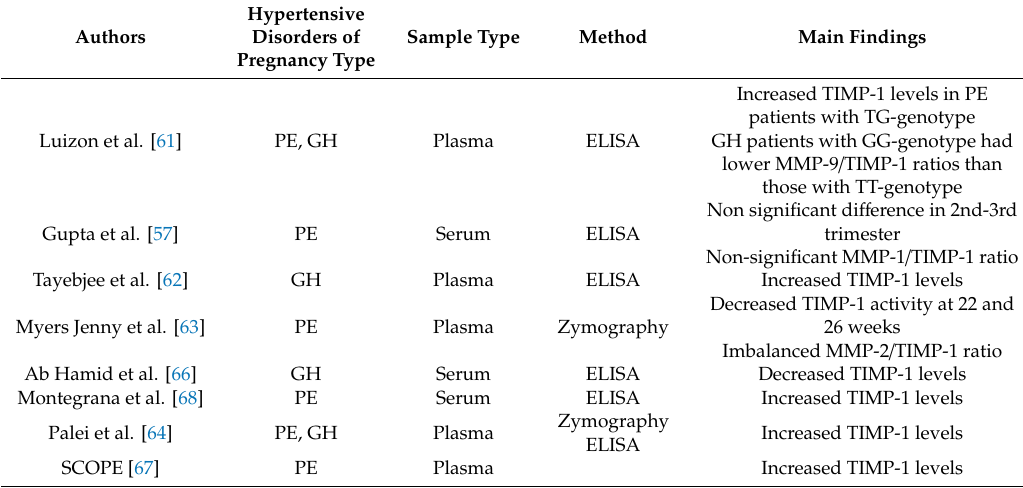
Table 2. Levels of tissue inhibitor of matrix metalloproteinase 1 (TIMP-1) in samples of patients with hypertensive disorders of pregnancy.